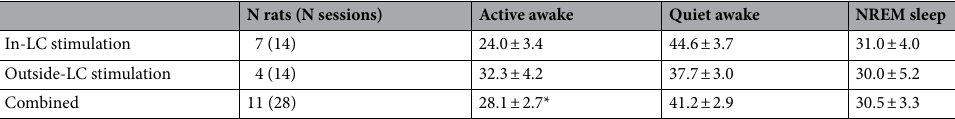
Table 2. The awake/sleep states during testing. Percent session time is shown. *p < 0.05 for between-state comparison (Bonferroni